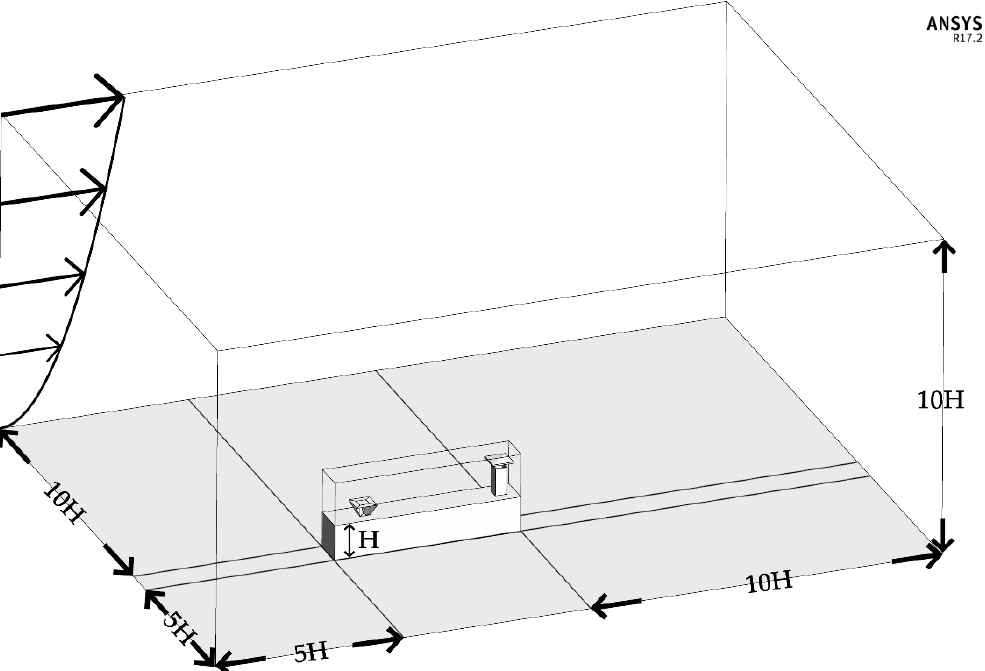
Figure 6. Dimensions of the domain for CFD simulations, H = 6.60 m and it represents the height of the building. Table 1. General cell sizes of the simulated